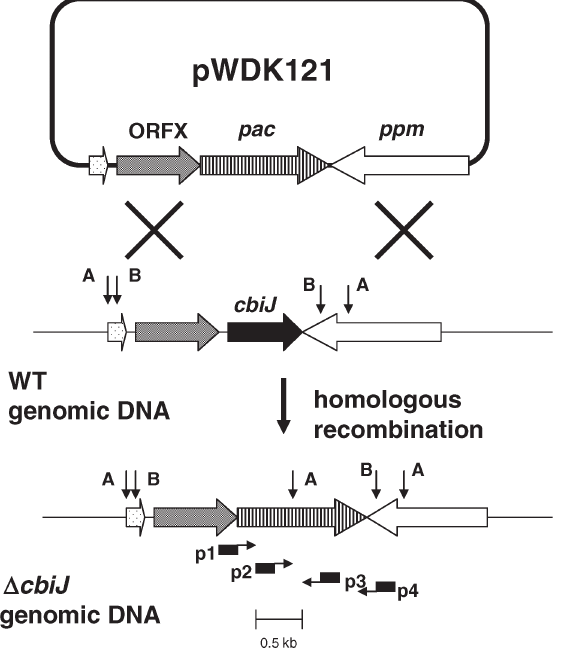
Figure 2. Scheme for construction of the cbiJ deletion ( Δ cbiJ ) by gene replacementin M. maripaludis . A and B indicate locationsof the restriction sites for Acc I and Bam HI, which were used during the Southern hybridization.Also, locationsof primersp1–p4 for the PCR are